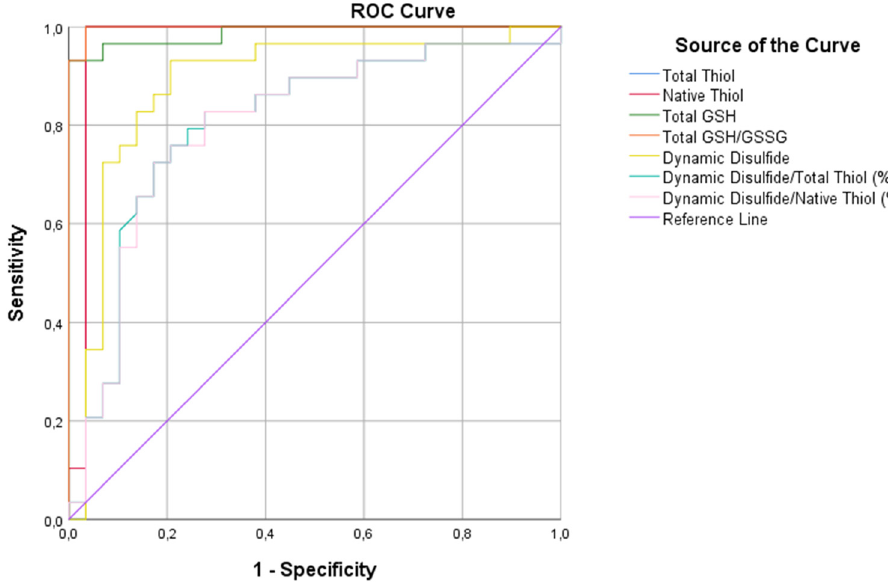
Figure 1: ROC curve of TT, SH, total GSH, total GSH/GSSG, dynamic SS, dynamic SS/TT ( % ) , and dynamic SS/SH ( % )